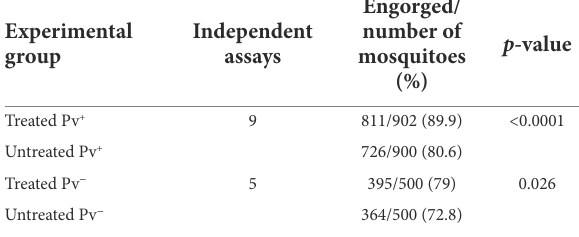
TABLE 3 Engorgement rate of Anopheles darlingi treated and untreated with antibiotics, and fed on Plasmodium vivax sample blood or uninfected